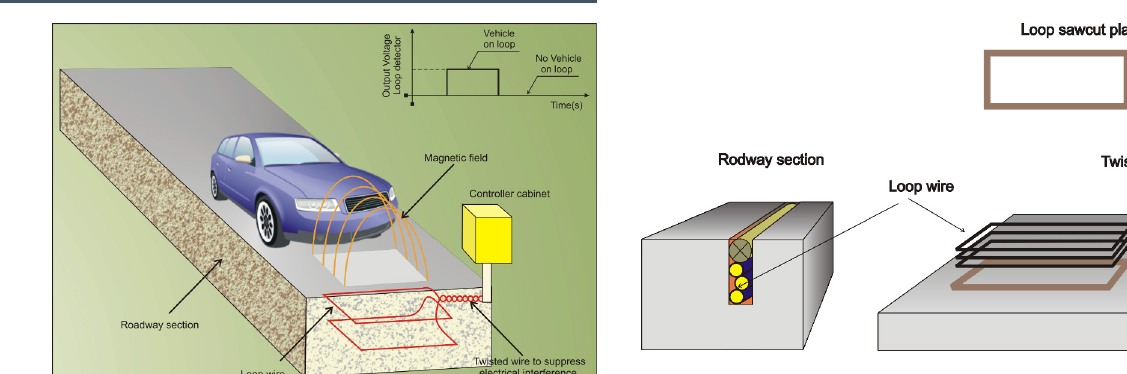
Figure 2. Example of loop in the roadway section